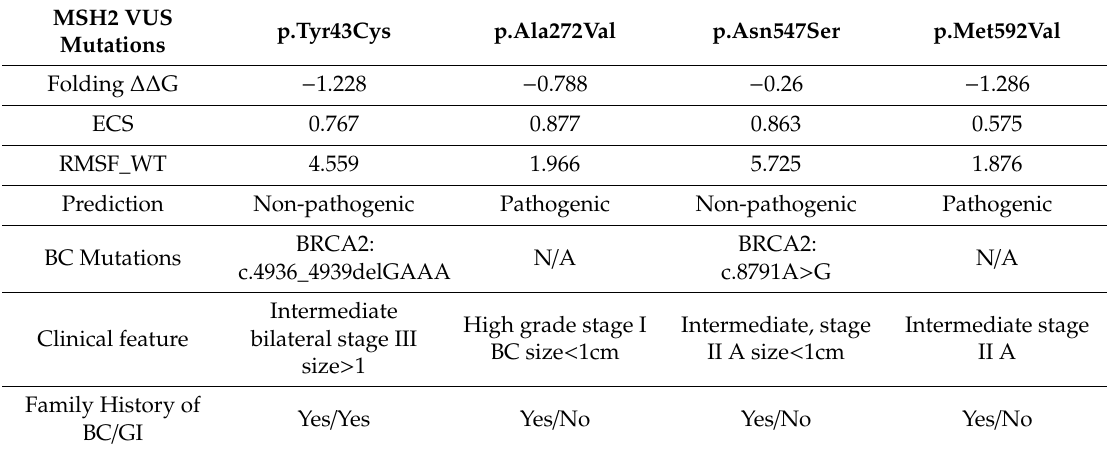
Table 2. Physicochemical characteristics and thermodynamic parameters of VUS with prediction results and clinical data. Folding ∆∆ G: Folding free energy change; ECS: Evolutionary conservation